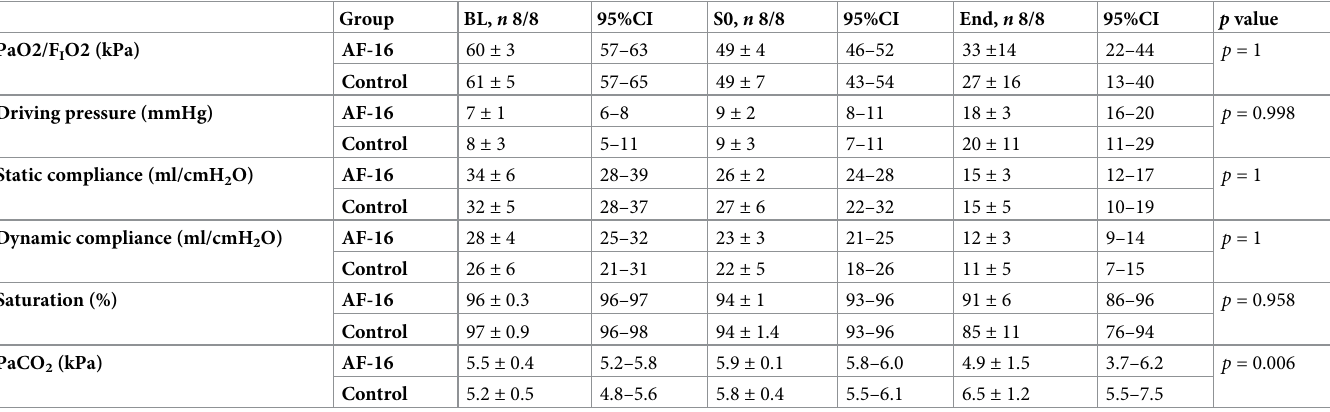
Table 2. Respiratory